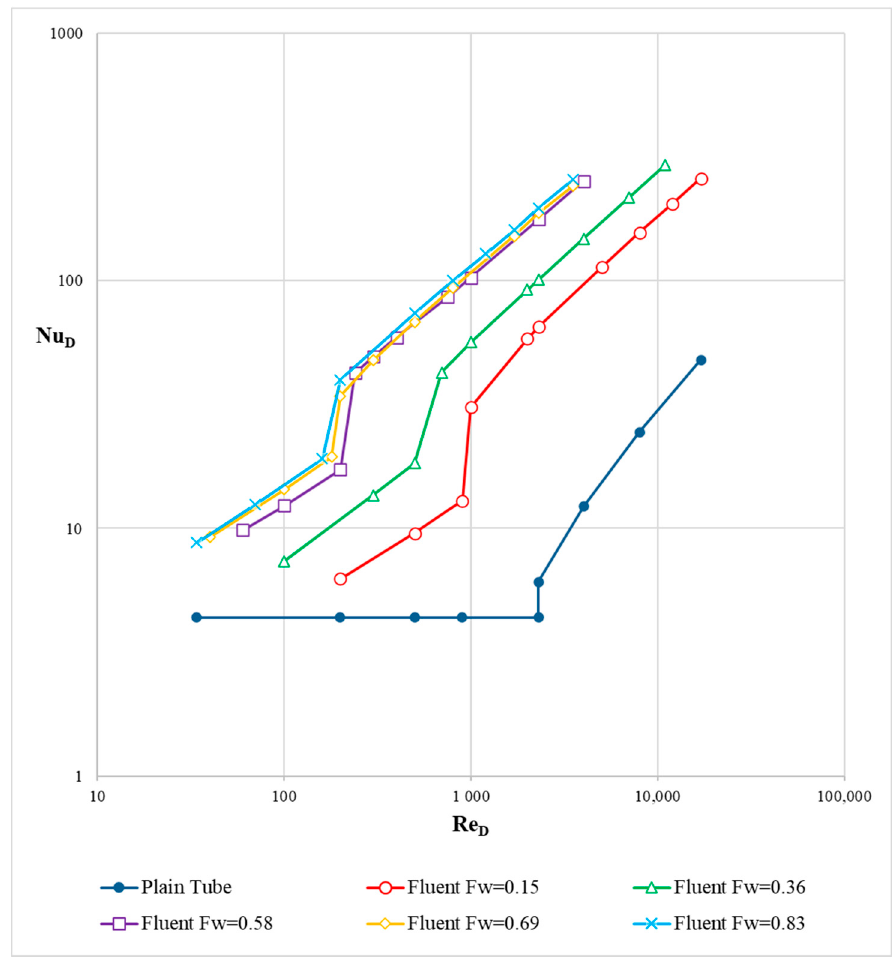
Figure 11. Averaged Nusselt number as a function of Reynolds number and wave factor.